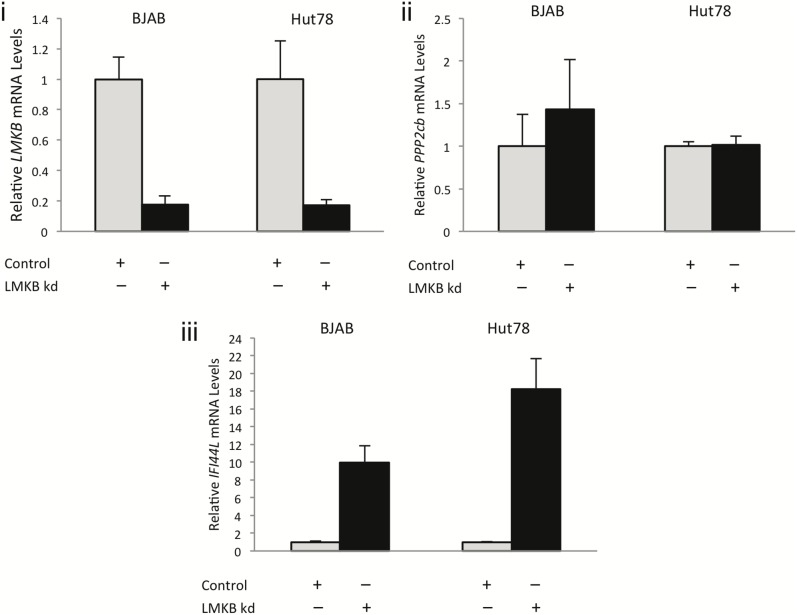
The effects of LMKB depletion on gene expression in BJAB and Hut78 cells. SiRNA-mediated knock-down of LMKB in BJAB and Hut78 cells resulted in a greater than 80% decrease in the level of LMKB mRNA (i). LMKB depletion had no effect on the level of PPP2cb mRNA in either cell line (ii). The level of IFI44L mRNA was increased in both BJAB and Hut78 cell lines after LMKB knock-down (iii).